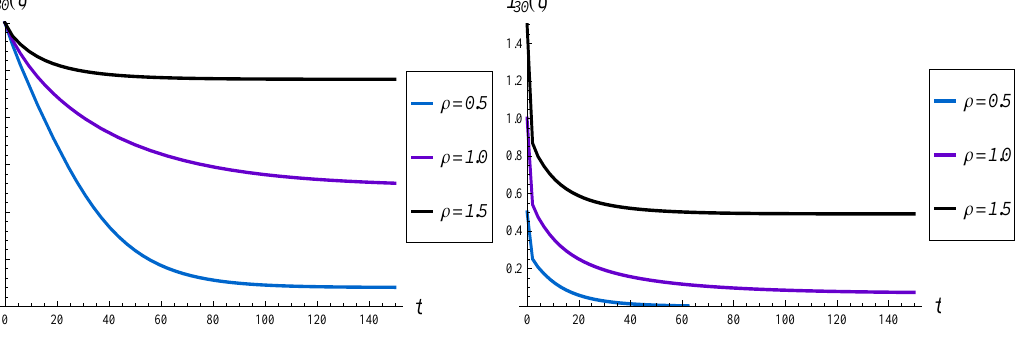
Figure 6. Average waiting time (on the left) and intensity of losses (on the right) vs. time, for different loads of the queue.